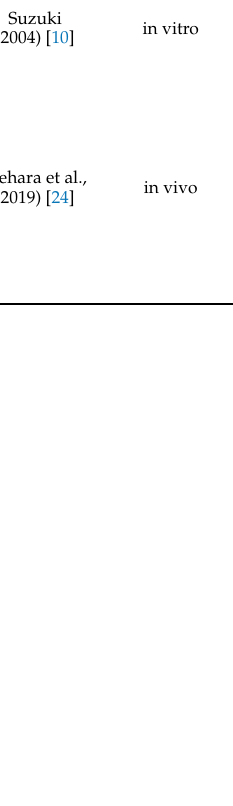
Table 4. Main findings of the selected studies on denture teeth wear